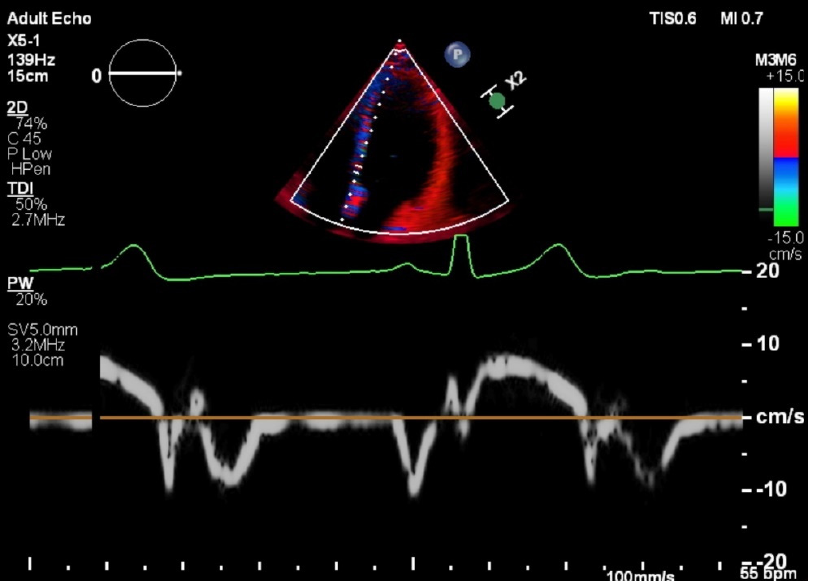
Figure 2. Tissue Doppler imaging echocardiography of a healthy pregnant patient in apical 4 chamber view, septal interogation–MV e’ Vel lat (mitral valve e wave velocity), MV a’ Vel lat (mitral valve a wave velocity), MV s’ Vel lat (mitral valve s wave velocity), E/E’ lat = relaxation ratio (E peak early